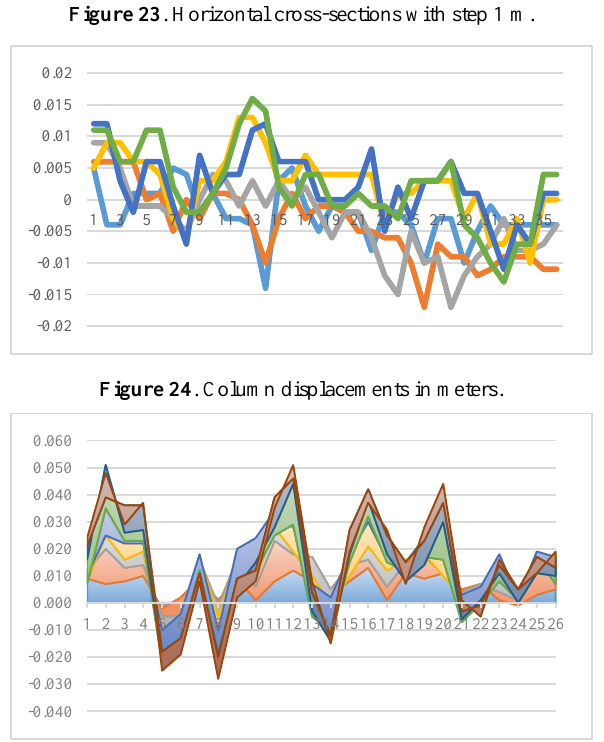
Figure 25 . Plate thickness deviations in